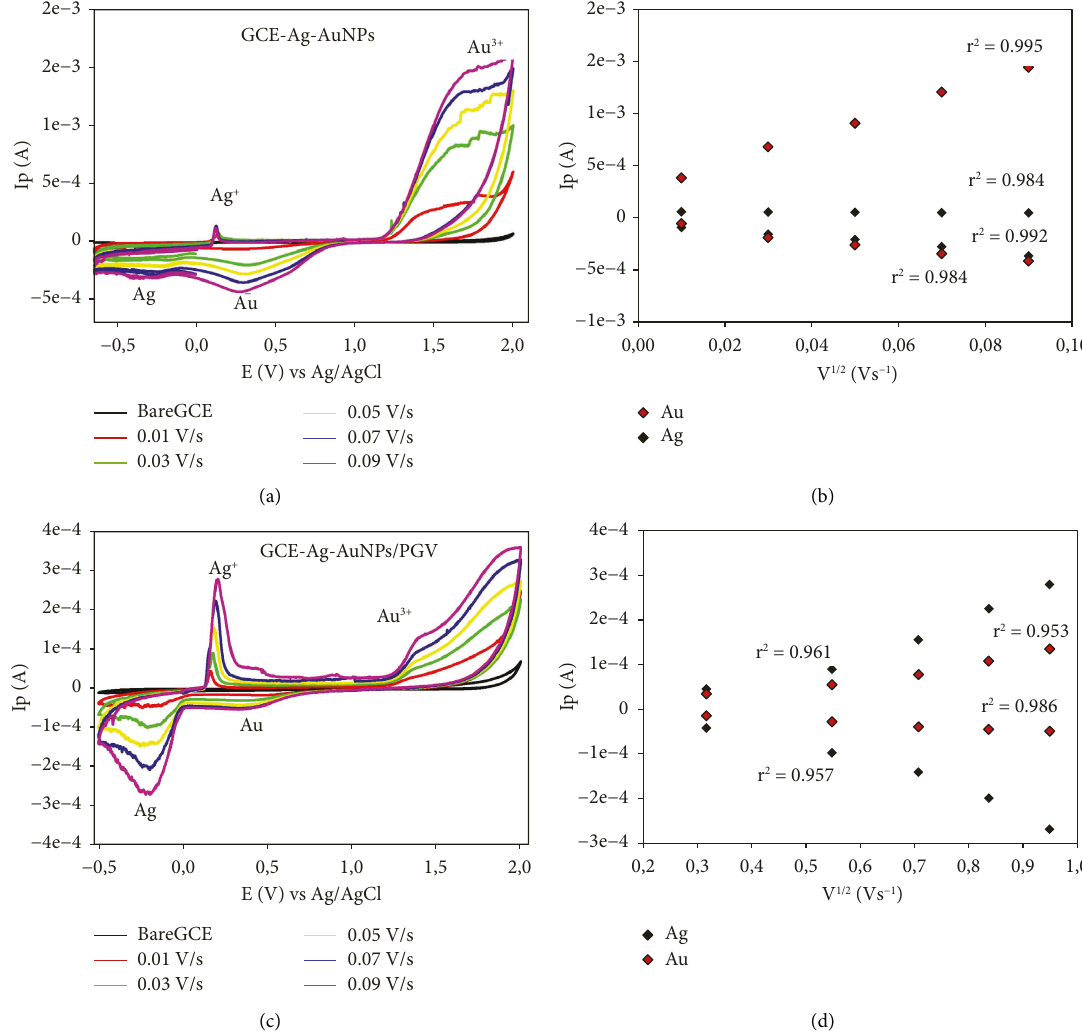
Figure 4: Overlay of various scan rates studies (a, c) for bimetallic and bimetallic bentonite composite, respectively. Randle’s linear dependence plots (b, d) for Ag-AuNPs and Ag-Au/PGV bentonite, respectively, in the 0.1 M HCl supporting